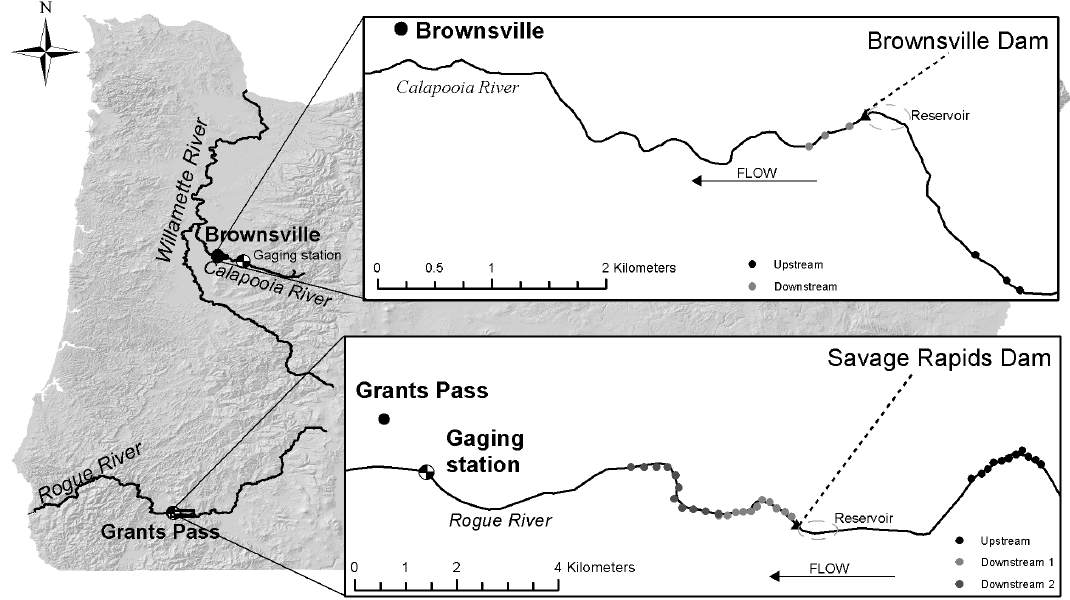
Figure 1. Site locations. Each dot represents a macroinvertebrate sampling location: 3 riffles per reach on the Calapooia River, and 11 transects per reach on the Rogue River.